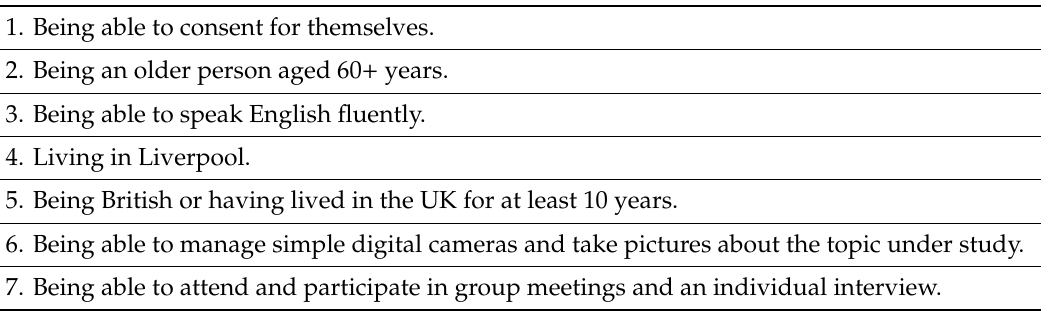
Table 1. Inclusion criteria of study